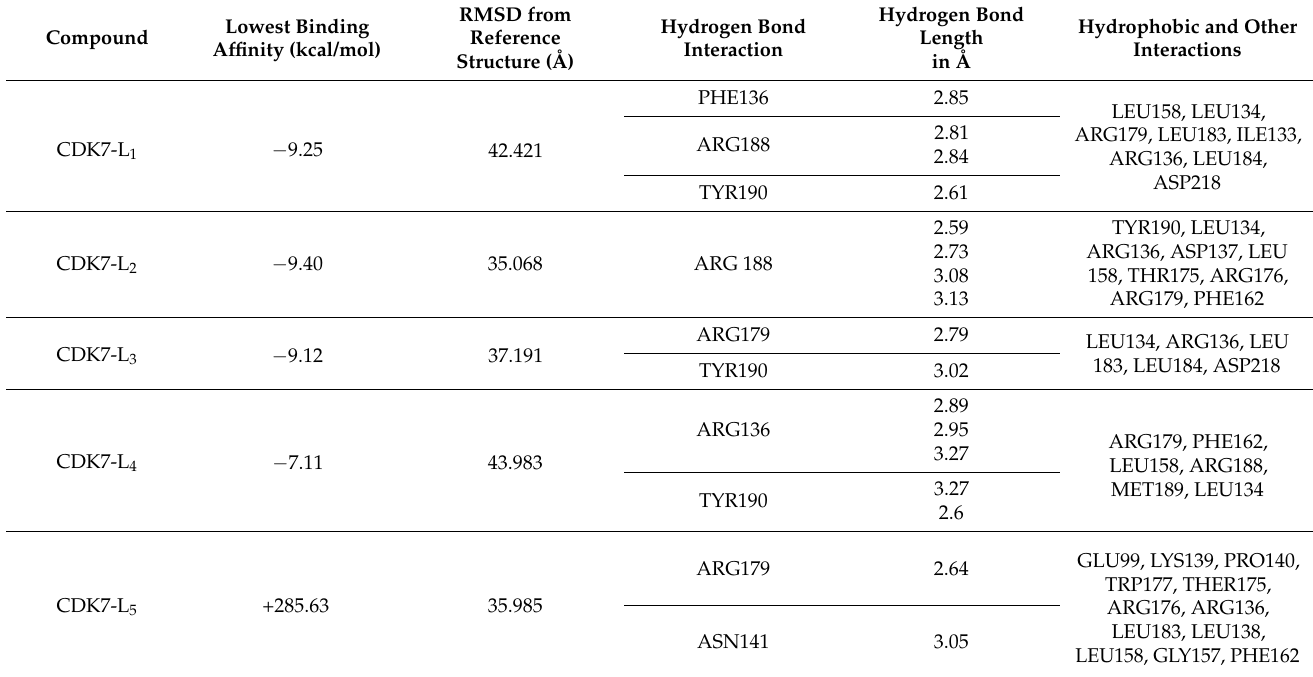
Table 7. The Binding values of Schiff base ligands with CDK-7